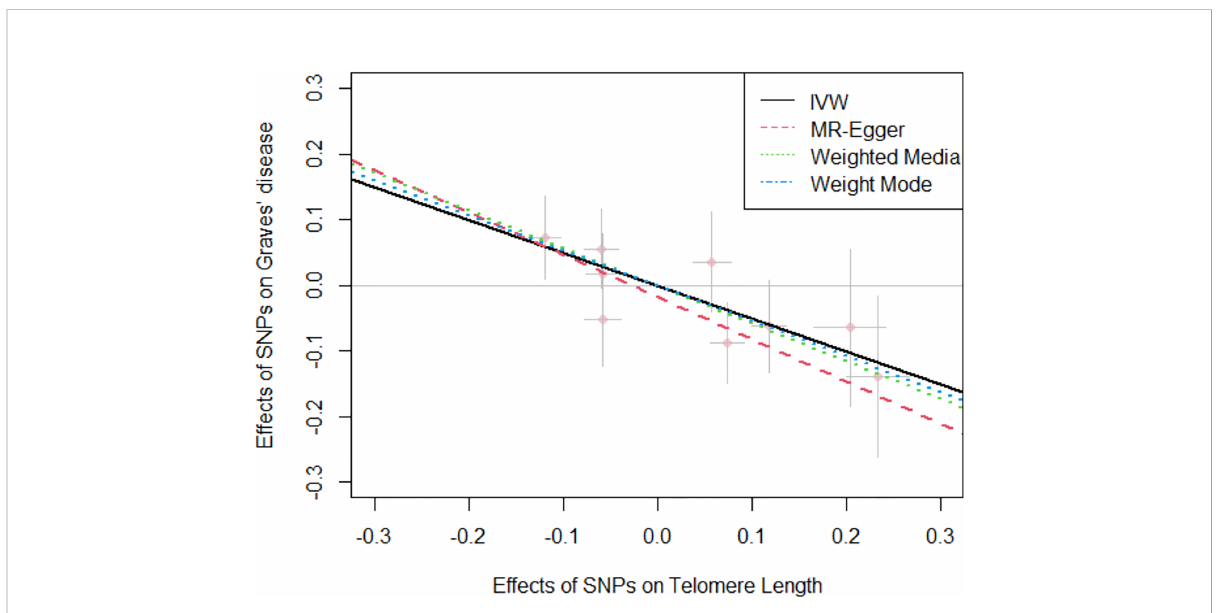
FIGURE 2 Scatter plot for the negative effects of SNPs on telomere length and Graves ’ disease. The horizontal and vertical axes represent the effects of each genetic variant on both telomere length and Graves ’ disease. The grey lines around the solid pink points denote the corresponding 95% CI for the effects. The slopes of solid lines show the effect estimates from four MR approaches. IVW, inverse variance weighted; MR, Mendelian randomization; SNPs, single nucleotide polymorphisms; CI, con fi dence interval.